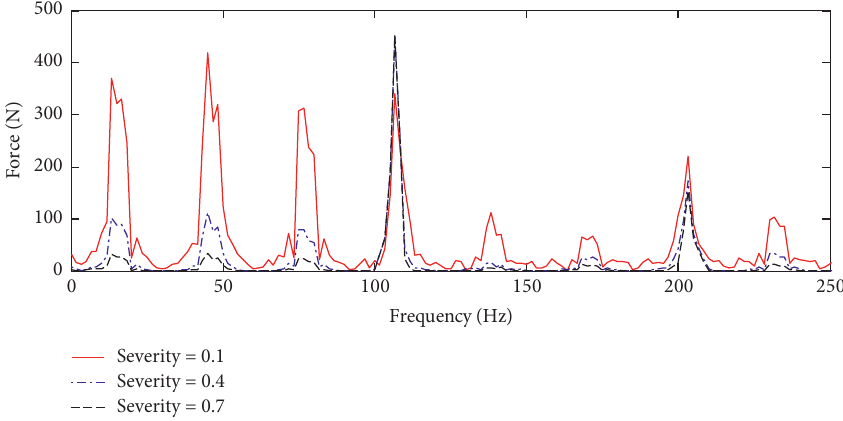
Figure 28: Meshing force of s- p